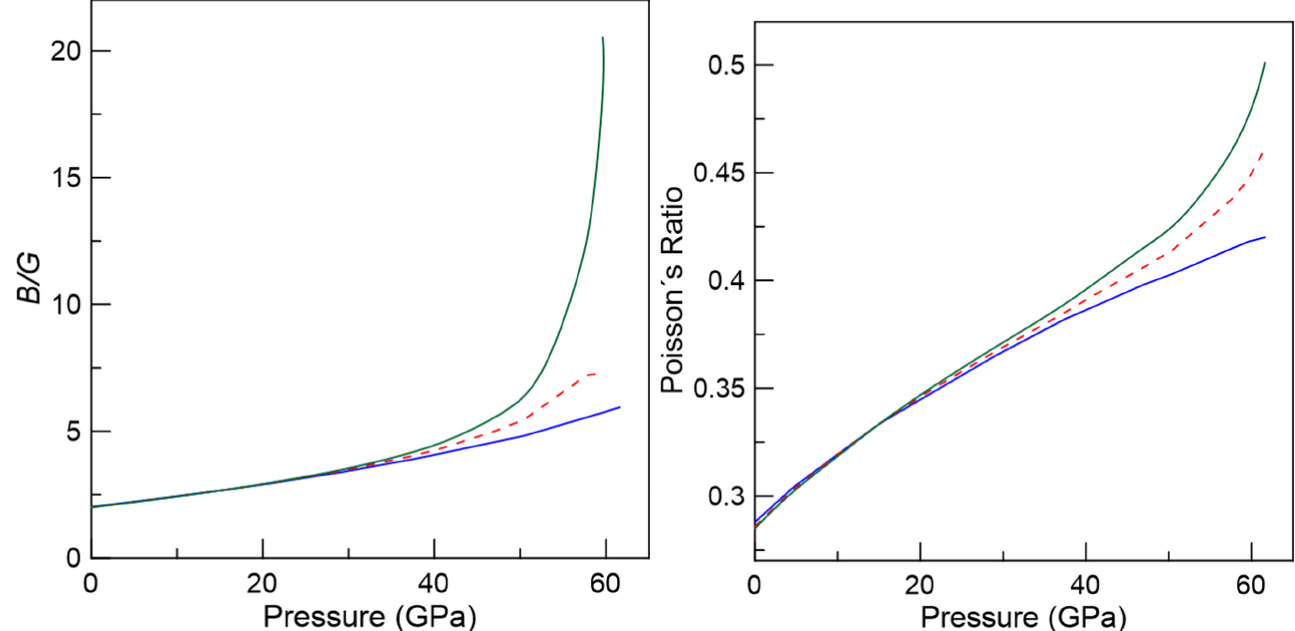
Figure 8. ( left ) Pressure evolution of the B/G ratio of DyScO 3 perovskite. ( right ) Pressure evolution of the Poisson’s ratio. The blue line represents the moduli in the Voigt approximation, the green line in the Reuss approximation, and the red one in the Hill